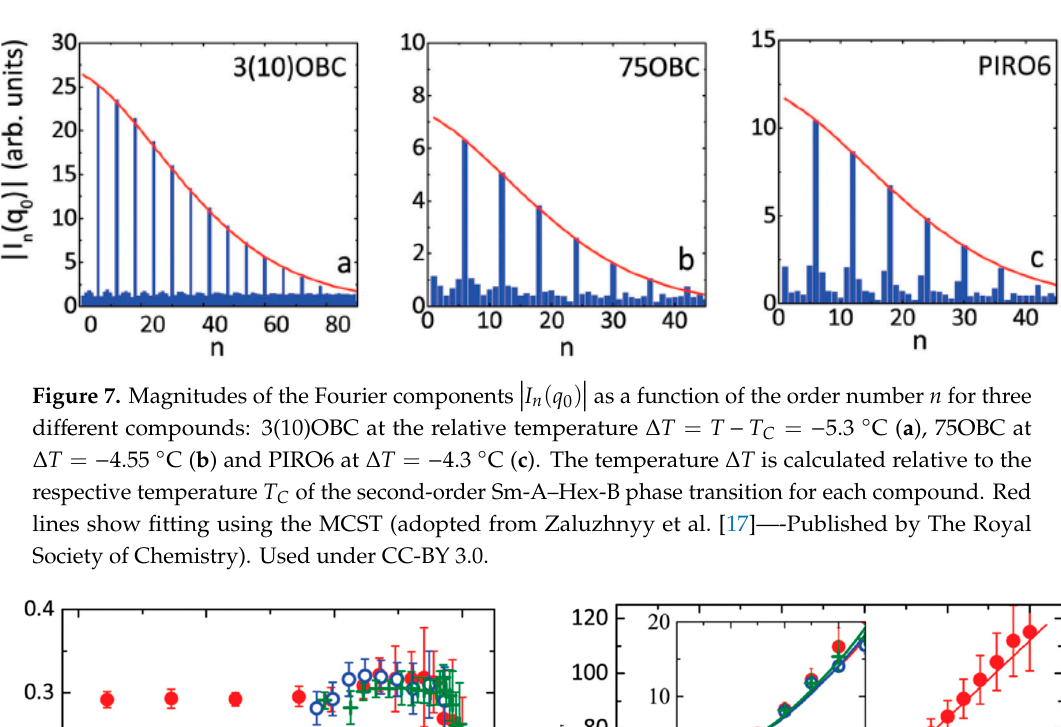
12 of 30 The parameter 𝑥 (cid:3040) can be represented as the Taylor series given in Equation (18): 𝑥 (cid:3040) ≈ 𝜆 − 𝜇𝑚 + 𝜈𝑚 (cid:2870) . (18) Using the renormalization group approach, Aharony et al. [39,63] evaluated the value of the parameters of the MCST to be 𝜆 = 0.3 and 𝜇 = 0.008 in 3D hexatics. The theoretical estimation of the quadratic correction term 𝜈 has never been carried out because of the required excessive computational efforts. It was also shown that in the 2D hexatic phase 𝑥 (cid:3040) = 1 , which significantly simplifies the scaling relation (see Equations (16) and (17)) [66]. Experimental verification of the MCST predictions is complicated due to the necessity of the accurate determination of the BO order parameters 𝐶 (cid:2874)(cid:3040) . In the diffraction experiment on the 8OSI compound (racemic 4-(2'-methylbutyl)phenyl 4'-(octyloxy)-(1,1')-biphenyl-4-carboxylate), by fitting the azimuthal dependence of the scattered intensity with Equation (6), it was possible to evaluate the values of 𝐶 (cid:2874)(cid:3040) up to 𝑚 = 7 , which allowed one to obtain 𝜆 = 0.295 [39]. In Refs. [17,67] diffraction patterns from n-propyl-4’-n-decyloxybiphenyl-4-carboxylate (3(10)OBC), n-heptyl-4’-n-pentyloxybiphenyl-4-carboxylate (75OBC) and 1-(4’pirydyl)-3-(4-hexyloxyphyenyl- oamine)-prop-2-en-1-on (PIRO6) LC compounds were analyzed by AXCCA. The values of the BO order parameters 𝐶 (cid:2874)(cid:3040) were directly evaluated as a square root of the corresponding normalized Fourier coefficients of the CCF 𝐶 (cid:2874)(cid:3040) = |𝐼 (cid:2874)(cid:3040) (𝑞 (cid:2868) )| |𝐼 (cid:2868) (𝑞 (cid:2868) )|⁄ = (cid:3495)(cid:3627)𝐶(cid:4632) (cid:2874)(cid:3040) (𝑞 (cid:2868) ) 𝐶(cid:4632) (cid:2868) (𝑞 (cid:2868) )⁄ (cid:3627) . Due to the spatial uniformity of the sixfold BO order in the Hex-B films over the range of about 100 μ m in hexatic monodomains, the magnitude of the angular modulation along the scattering ring remained almost constant at different positions. This allowed averaging the CCFs over 100 diffraction patterns for the 3(10)OBC and PIRO6 compounds and over 25 patterns for the 75OBC compound. As a consequence of such evaluation of the BO order parameters, it was possible to determine up to 𝑚 (cid:2923)(cid:2911)(cid:2934) = 25 successive Fourier components for 3(10)OBC, and 𝑚 (cid:2923)(cid:2911)(cid:2934) = 7 for 75OBC, and 𝑚 (cid:2923)(cid:2911)(cid:2934) = 6 for PIRO6, respectively. The magnitudes of the angular Fourier components of intensity |𝐼 (cid:3041) (𝑞 (cid:2868) )| in the Hex-B phase for different compounds are shown in Figure 7. The FCs of the order n, which are not divisible by six have vanishingly small values on the noise level. In contrast, the sixfold FCs are much larger, indicating the presence of sixfold BO order in the system. The decay of the magnitudes |𝐼 (cid:2874)(cid:3040) (𝑞 (cid:2868) )| with 𝑚 ≥ 1 can be well fitted by the MCST law at any temperature point below the Sm-A–Hex-B transition for all three compounds (red lines in Figure 7). Although the MCST predicts 𝜆 = 0.3 for 3D Hex-B phase, the value of the parameter might change close to the Sm-A–Hex-B phase transition point. This was observed indeed for all three compounds [17,67], where 𝜆 was abruptly decreasing down to zero at the phase transition temperature (Figure 8a). However, away from the Sm-A–Hex-B phase transition temperature the